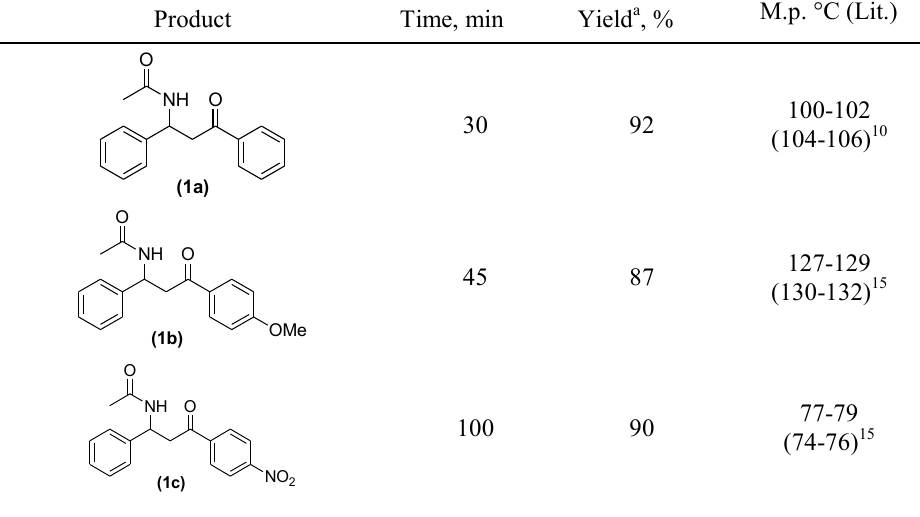
Table 2. The preparation of β-acetamido ketones from acetophenones, arylaldehydes, acetonitrile and acetyl chloride using